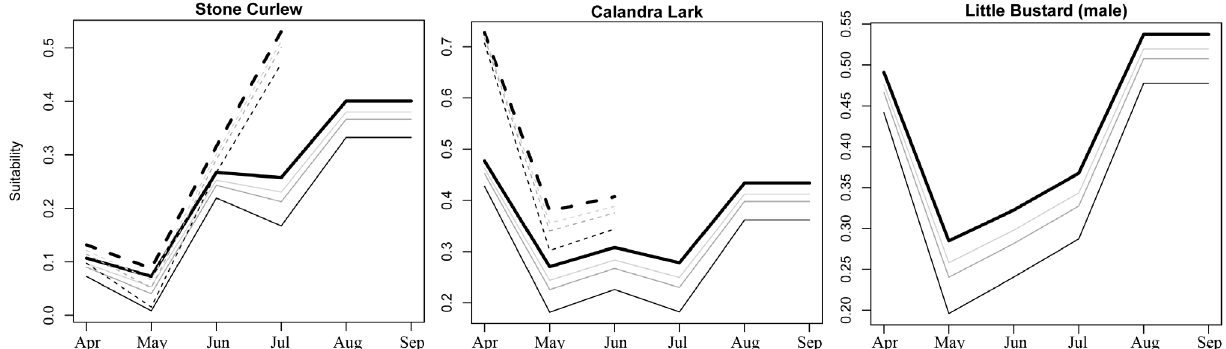
Figure 5. Temporal variation of predicted habitat suitability according to different key ecological requirements for Stone Curlew, Calandra Lark and male Little Bustard in the study area derived from current landscapes (thick black line) and from the loss of 30%, 50% and 100% of current fallow land in the study area (thin light grey, dark grey and black lines, respectively). Solid lines indicate foraging-related habitat suitability, while dashed lines indicate nesting-related habitat suitability.